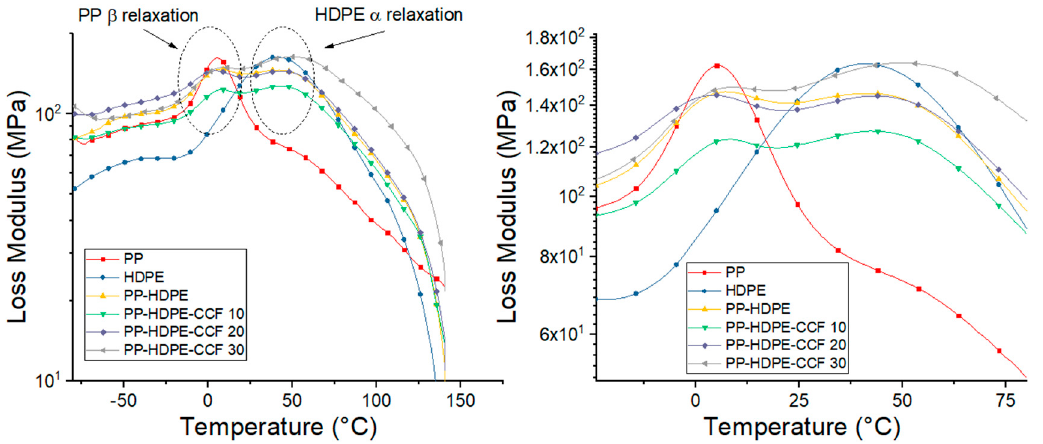
Figure 10. Temperature dependence of loss modulus of PP, HDPE, PP-HDPE blend, and their biocomposites.